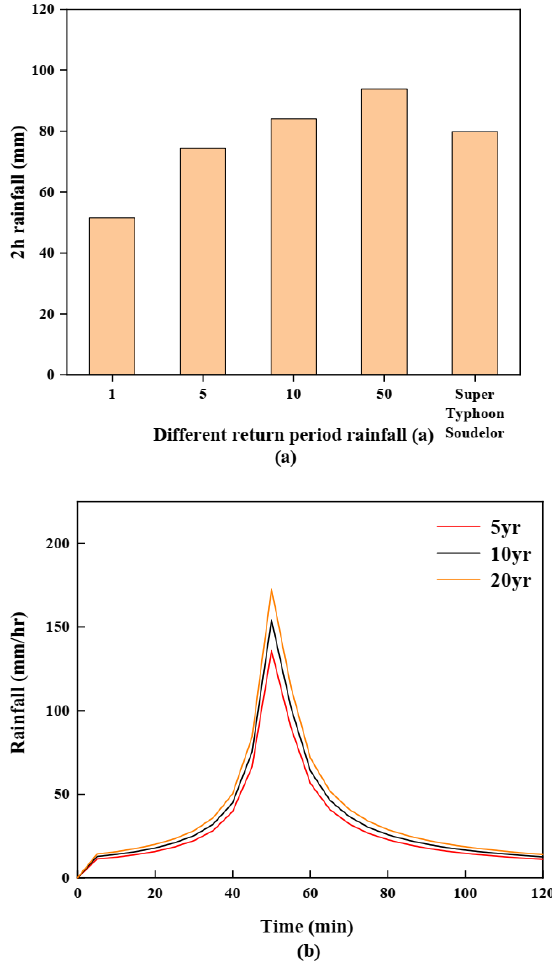
Figure 4. Information about rainfall in this study: ( a ) the comparison of different rainfall; ( b ) rainfall intensity of different return period